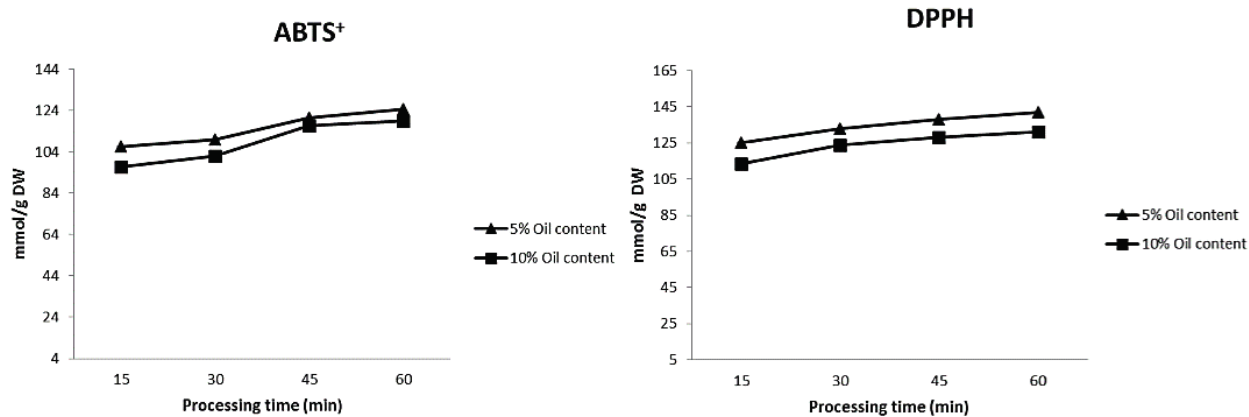
Figure 1. Changes in antioxidant capacity during processing